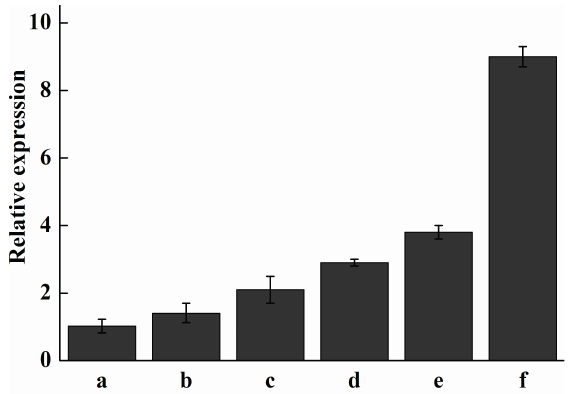
Figure 7. Analysis of expression levels of Pc-fps in P. cocos at various developmental stages. (a) 5-day-old mycelium; (b) 10-day-old mycelium; (c) 15-day-old mycelium; (d) 20-day-old mycelium; (e) 30-day-old mycelium; (f) primordia.